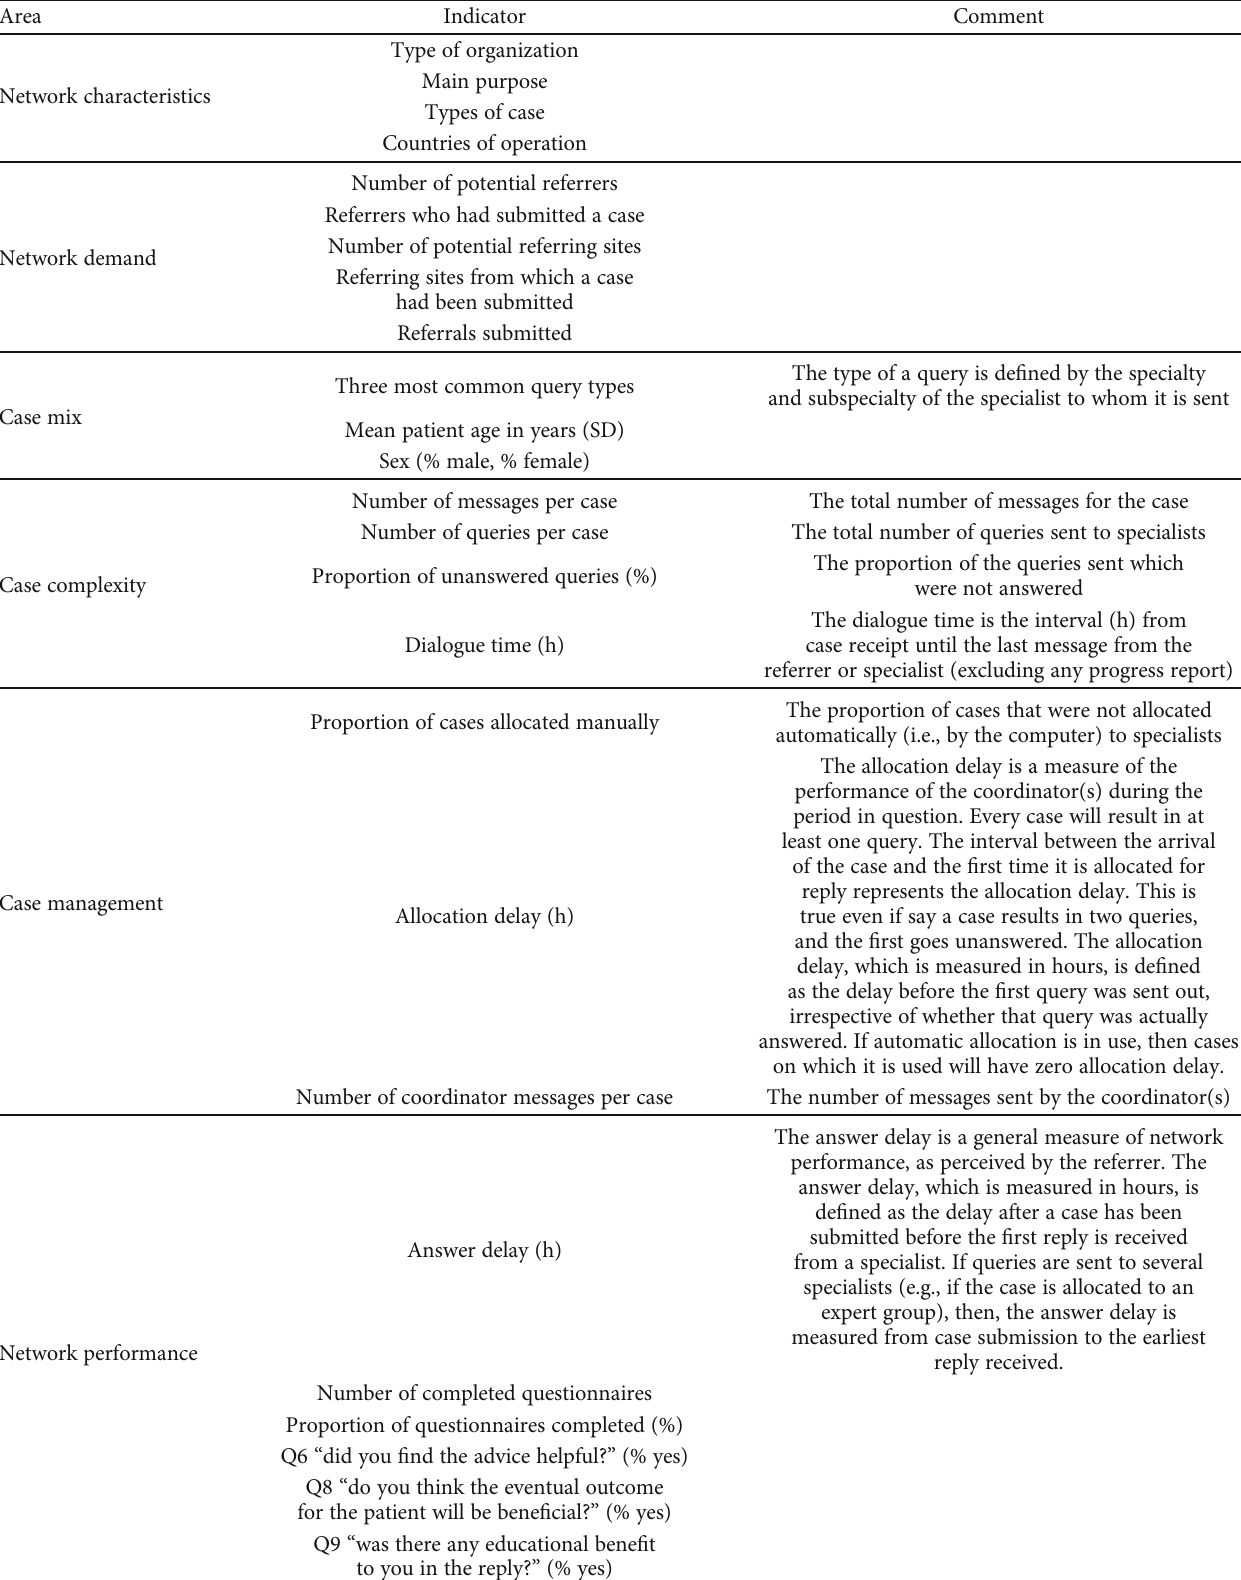
Table 1: Principal indicators used in the present